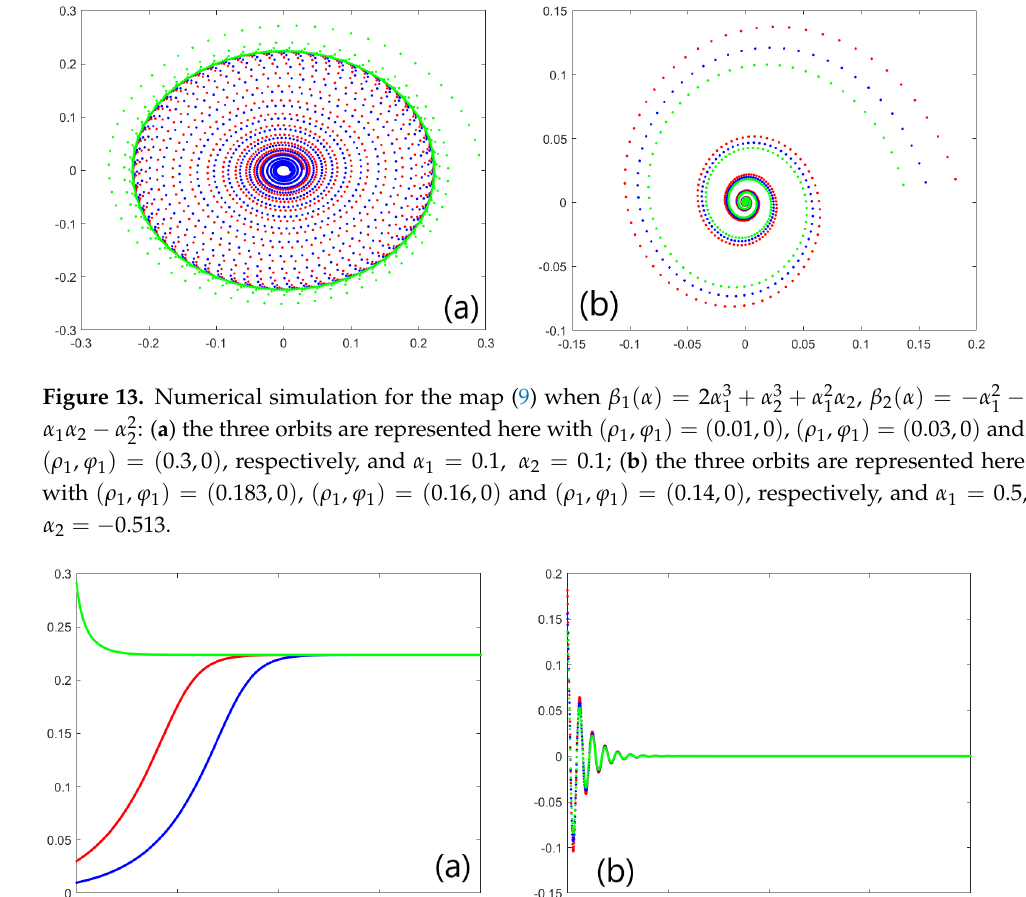
Figure 14. The discrete sequence ρ n given by the map (9) in the plane ( nO ρ n ) when β 1 ( α ) = + α 3 − α − α 2 + α 2 α 2 , β 2 ( α ) = − α 2 2 α 3 : ( a ) when ( ρ 1 , ϕ 1 ) = ( 0.01,0 ) , ( ρ 1 , ϕ 1 ) = ( 0.03,0 ) , 1 α 2 2 2 1 1 1 ( ρ ) = ( 0.284,0 ) and a = 0.1, a = 0.1; ( b ) when starting points are as in Figure 13b. 2 1 , ϕ 1 1 2 + 2 α 3 − α − α 2 α 2 , β 2 ( α ) = − α 1 − 3 α 2 , α 1 = 0.1, α 2 = − Now choosing β 1 ( α ) = α 3 1 α 2 2 1 1